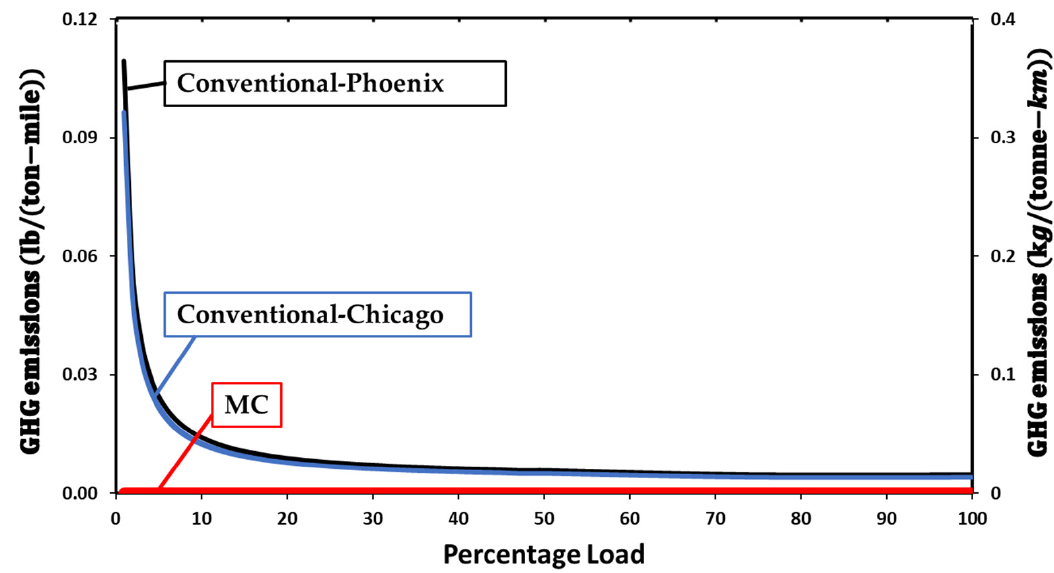
Figure 7 . Indirect GHG refrigeration emissions for tomatoes in kg per tonne-km and lb per ton-mile in Phoenix and Chicago.